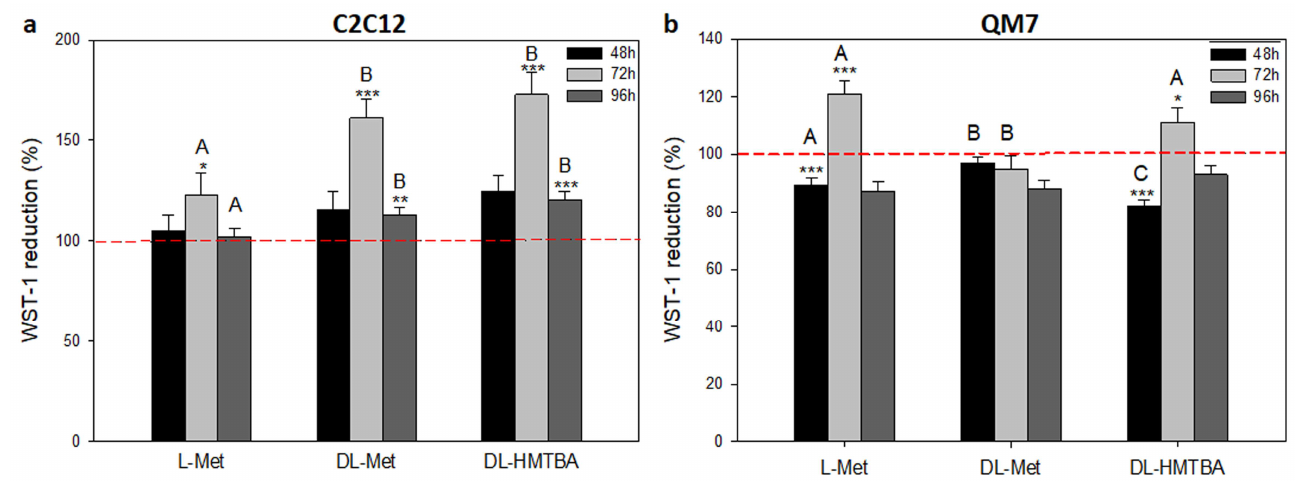
Figure 5. Effects of L-Met, DL-Met, and DL-HMTBA on cell viability and metabolic activity of C2C12 ( a ) and QM7 cells ( b ). C2C12 or QM7 cells were seeded at densities of 5000 or 10,000 cells per well, respectively. Metabolic activity was determined via WST-1 assay after 48, 72, or 96 h after applica- tion of 100 or 1000 µM of L-Met, DL-Met, or DL-HMTBA; tested concentrations were pooled since there were no statistical differences between them. In C2C12 cells, L-Met, DL-Met, and DL-HMTBA significantly increased cellular activity compared to unstimulated control cells. Contrastingly, in QM7 cells, L-Met and DL-HMTBA decreased metabolic activity after 48 h but increased it after 72 h. * p ≤ 0.05, ** p ≤ 0.01, and *** p ≤ 0.001 vs. control; A, B, and C uppercase letters show significant differences between supplements within a concentration value ( p ≤ 0.05); N = 10. 3.3. Effect of L-Met, DL-Met, and DL-HMTBA on Extracellular Hydrogen Peroxide Production We assumed that changes in metabolic activity as found in the WST-1 assay could be associated with alterations in ROS generation. For this reason, we tested the impact of